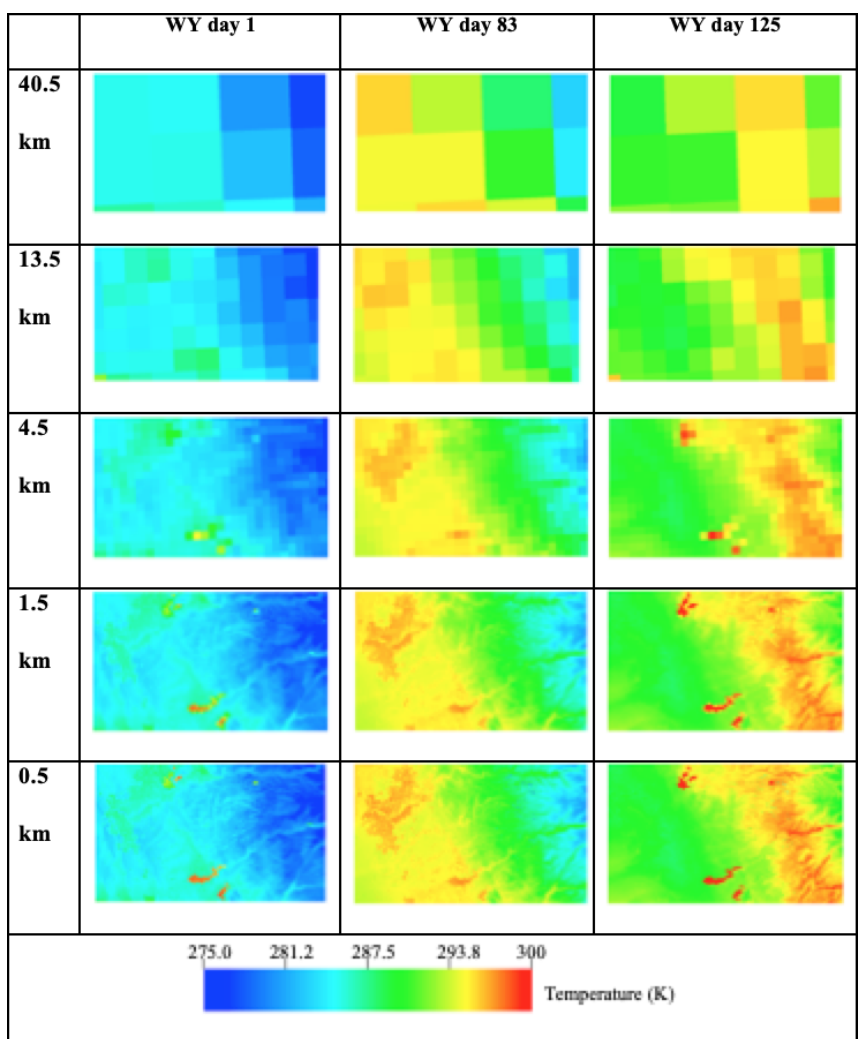
Figure A3. Spatial distributions of temperature associated with the five spatial resolutions of meteorological forcing at three selected times corresponding to periods where the storm has high (day 1) and low (day 83) intensity and a time of very located and low intensity (day